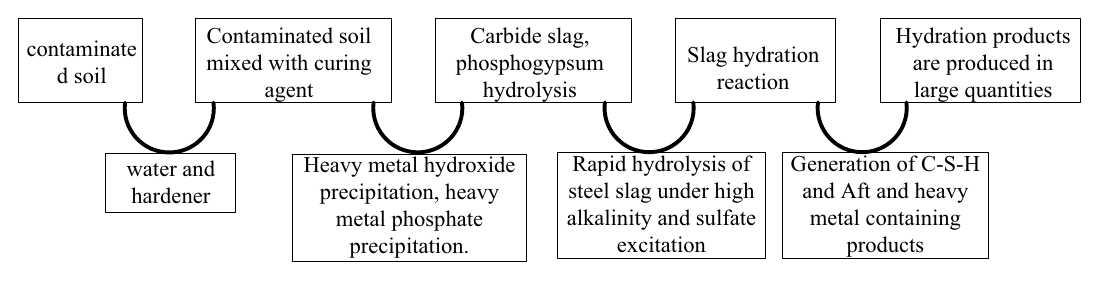
Figure 3. Grouping effects of sustainable curing agents.